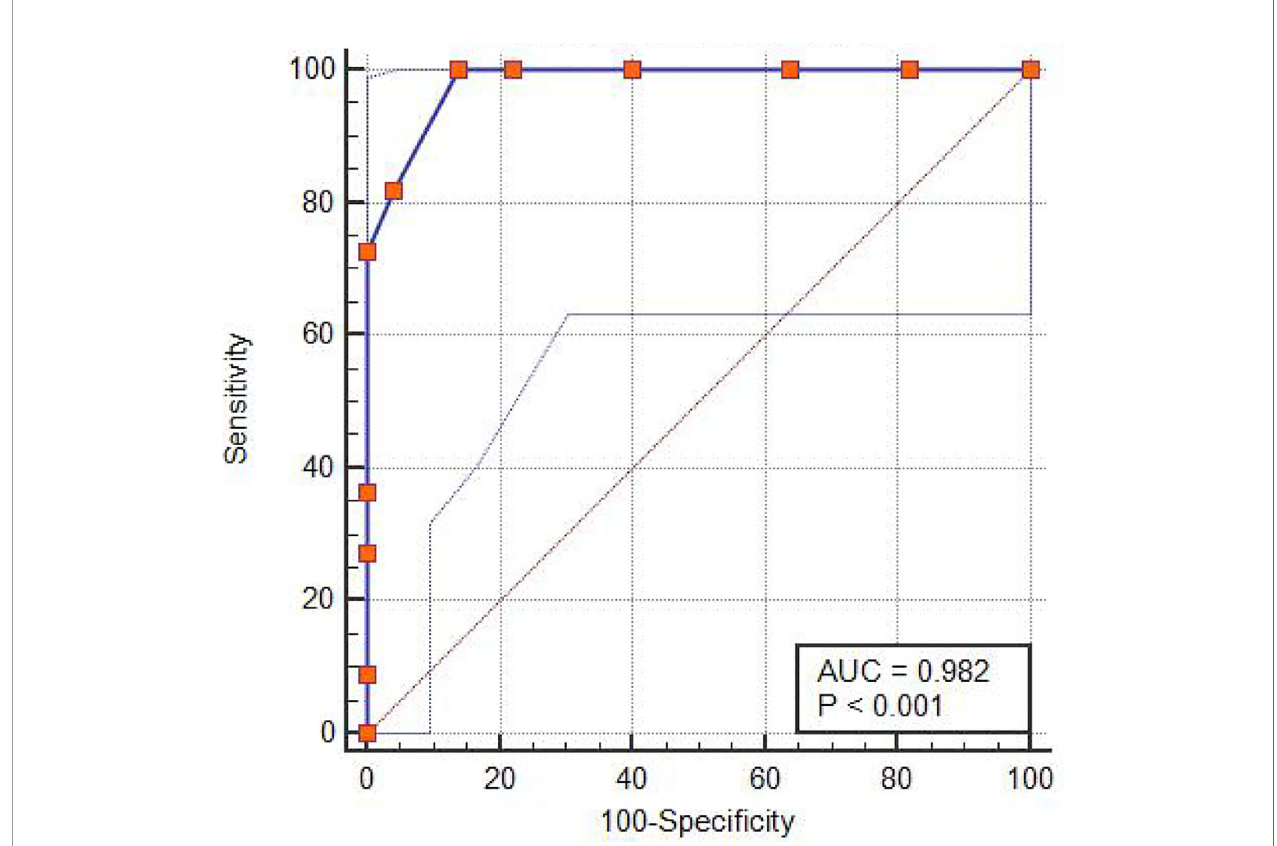
FIGURE 2 | ROC curve analysis for the BTO-positive group. The purple line with orange dots showing ROC curve analysis for the BTO-positive group detected by drop in rSO 2